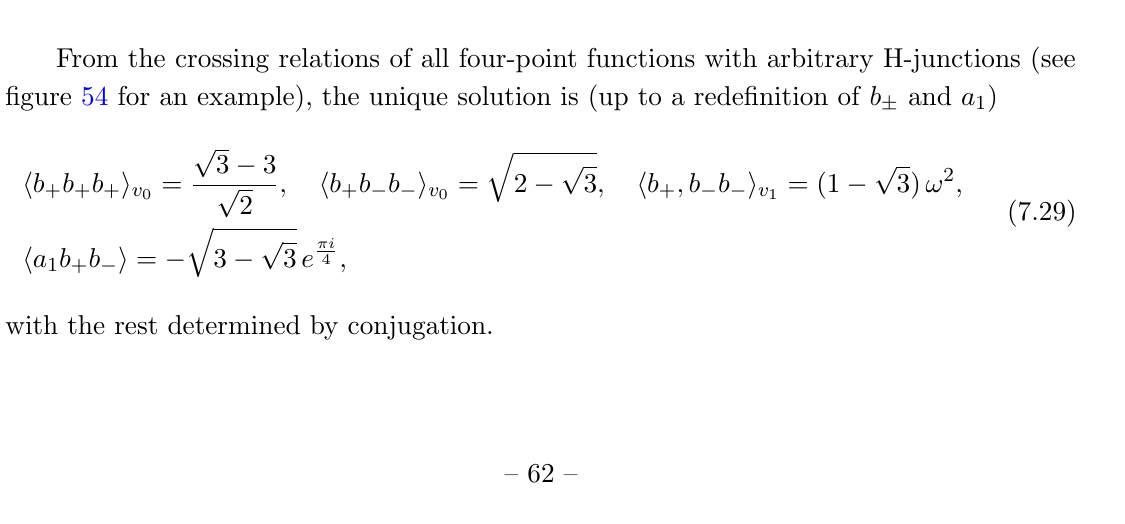
Figure 56 . Derivation of the last two lasso diagrams in (cid:12)gure 55. We start with three-point func- tions of defect operators a 2 and b (cid:6) which vanish identically, and then pass a 2 through the Y line via crossing. We thus obtain a set of four algebraic equations involving the structure constants (7.29), and the lasso diagrams of a 2 ending on b (cid:6) . Here, we display two of the four equations (the other two are obtained by setting the pair of defect operators in H Y to be b + ; b (cid:0) and b (cid:0) ; b + ). The unique solution to these equations is that all lasso diagrams of a 2 involving Y Y Y junctions